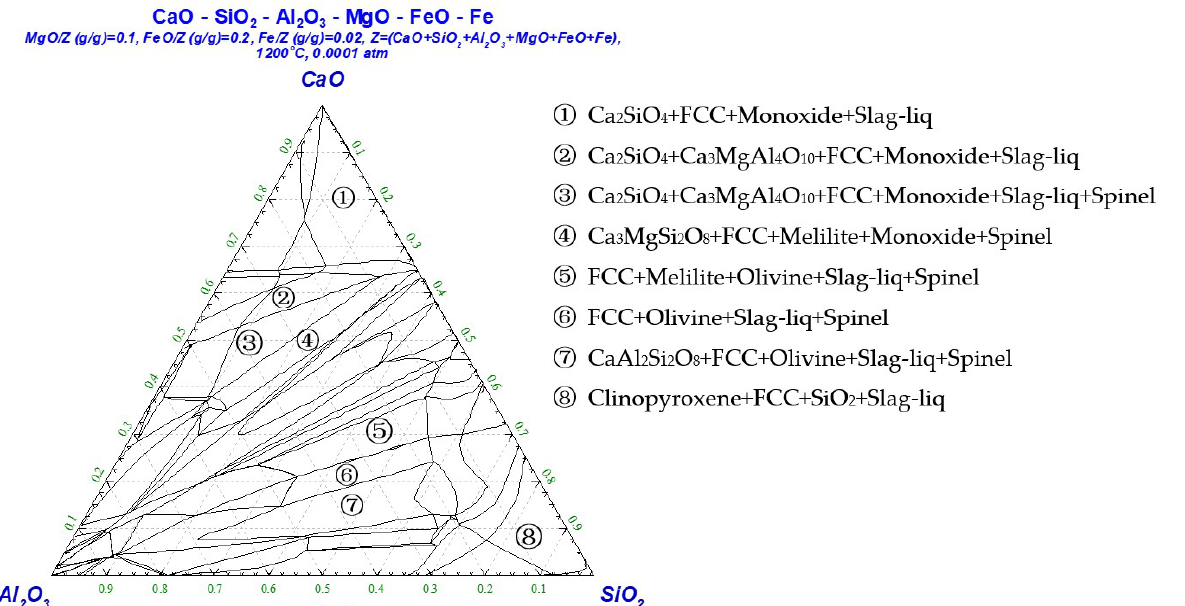
Figure 18. Back-scattered electronic image of porous 316 stainless steel with stronger magnetic separation iron oxide scale; ( a ) surface; ( b ) inside; ① the energy spectrum analysis of point ① ; and ② the energy spectrum analysis of point ① .